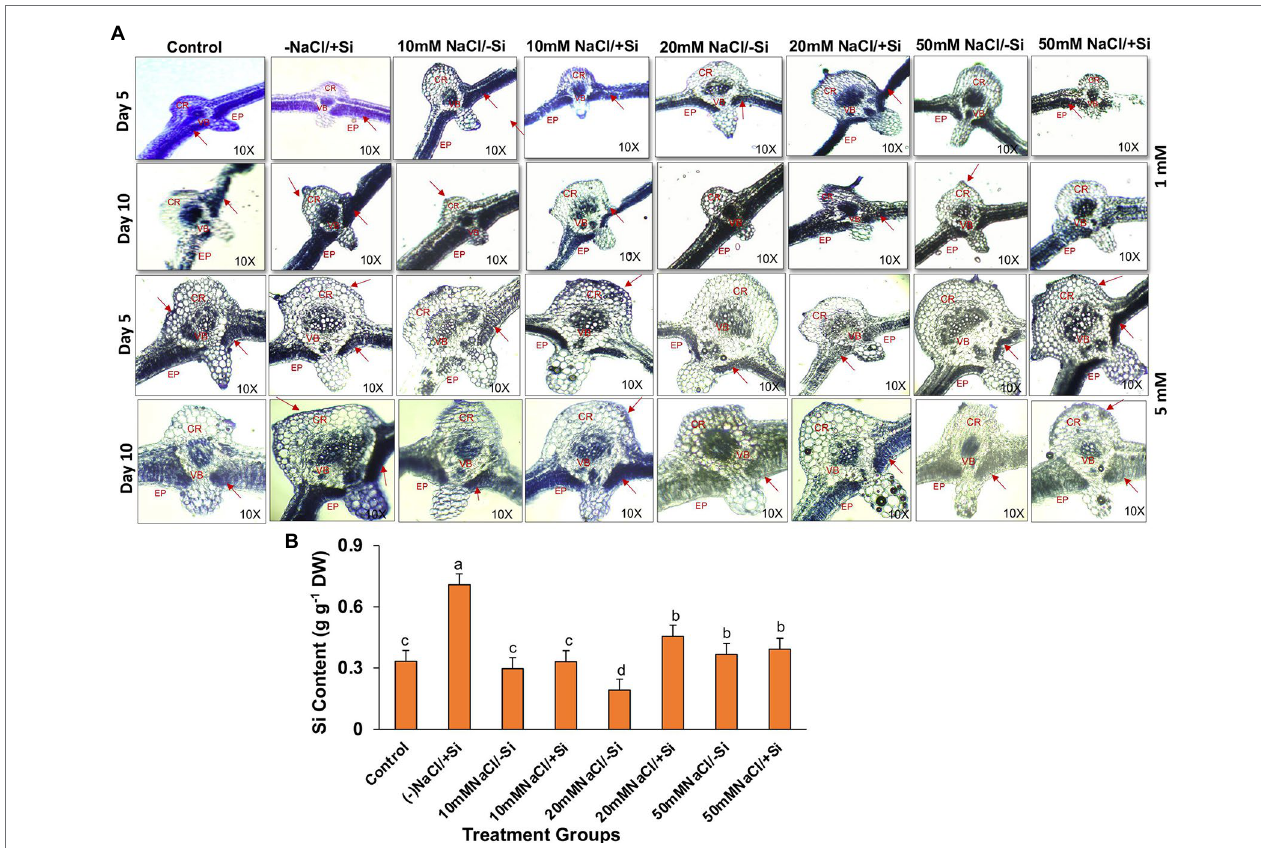
FIGURE 14 | (A) Silica deposition in mung bean ( Vigna radiata ) under 1 mM (Si 1 ) and 5 mM (Si 2 ) Si supply and salinity stress after eight treatments: (i) control (T1), (ii) − NaCl+Si (1 mM/5 mM) (T2), (iii) 10 mM NaCl/ − Si (T3), (iv) 10 mM NaCl/+Si (1 mM/5 mM) (T4), (v) 20 mM NaCl/ − Si (T5), (vi) 20 mM NaCl/+Si (1 mM/5 mM) (T6), (vii) 50 mM NaCl/ − Si (T7), and (viii) 50 mM NaCl/+Si (1 mM/5 mM) (T8) for a period of 5 and 10 days. EP indicates epidermis; CR indicates cortex; VB indicates vascular bundles. (B) Silicon concentration in mung bean ( Vigna radiata ) under 5 mM (Si 2 ) Si supply and salinity stress after 10 days of treatment. Vertical bars indicate Mean ± SE of the means for n = 4. Means denoted by the different letters are significantly different at p ≤ 0.05 according to the Tukey’s studentized range